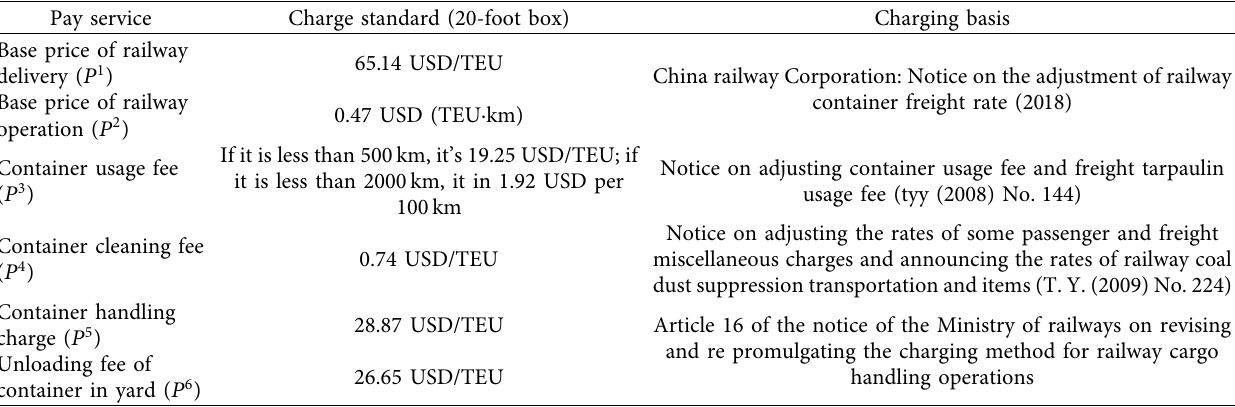
Table 5: Railway transport related charging